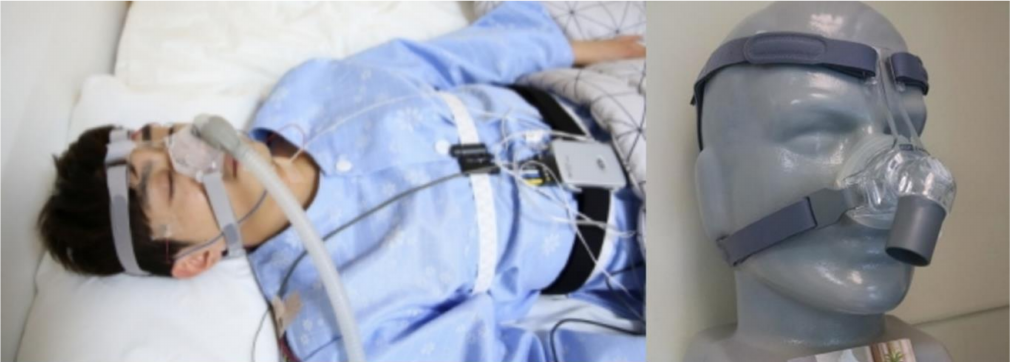
Figure 1. CPAP device for treating OSA.